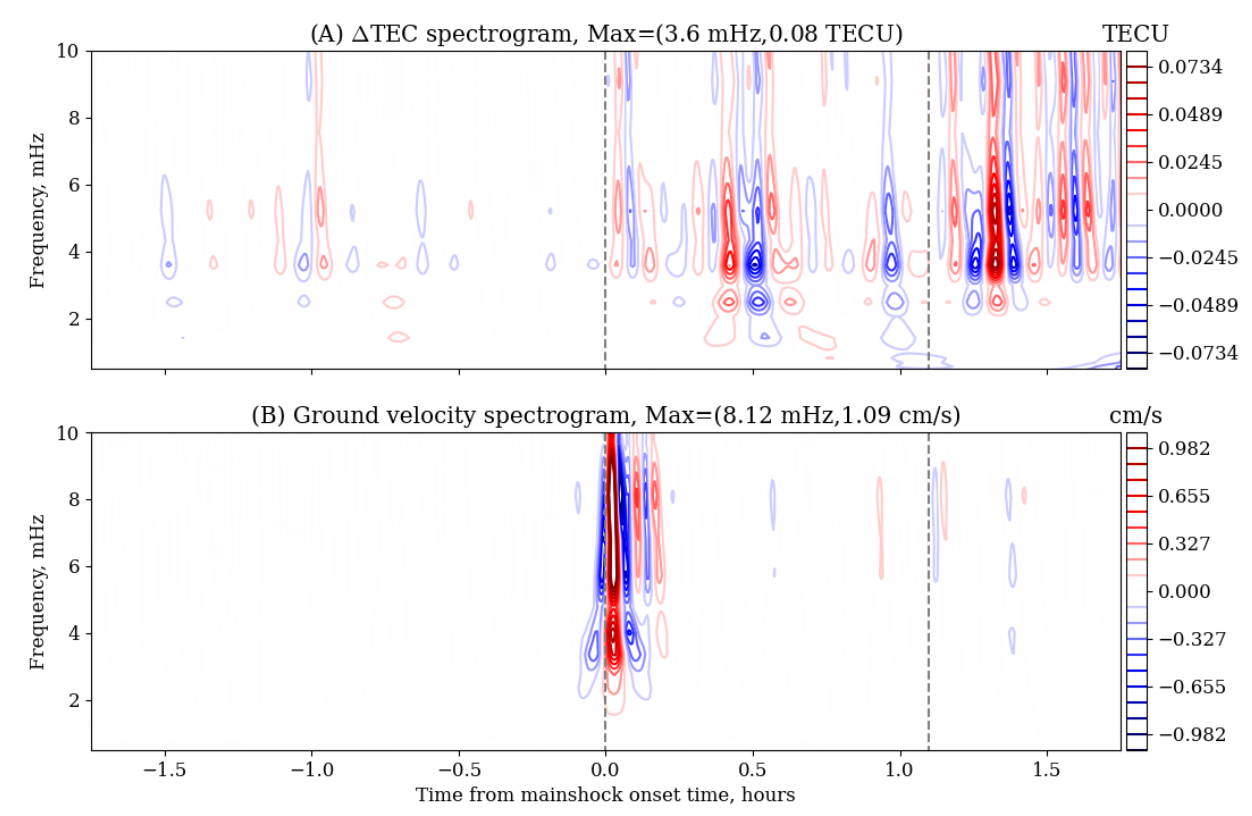
Figure 4. Spectrograms of the ∆ TEC ( A ) and the vertical ground velocity ( B ) on earthquake day (4 July 2019). Here, TEC and velocities are the averages over all the stations. Red and blue contours represent the positive and negative values, respetively, with the corresponding maximum values denoted as Max at the top of the panel. These maximum values belong to the 1–10 mHz frequency range. Vertical dashed lines indicate the onset time of the mainshock of Mw 6.4 and the aftershock of Mw 4.6. The time window of the data is ± 2.25 h; therefore, in 1–10 mHz, the data in ± 1.75 h remain unperturbed from the boundary effects arising from the filtering. For this reason, the time axis in this figure and in the rest of the figures is restricted to ±